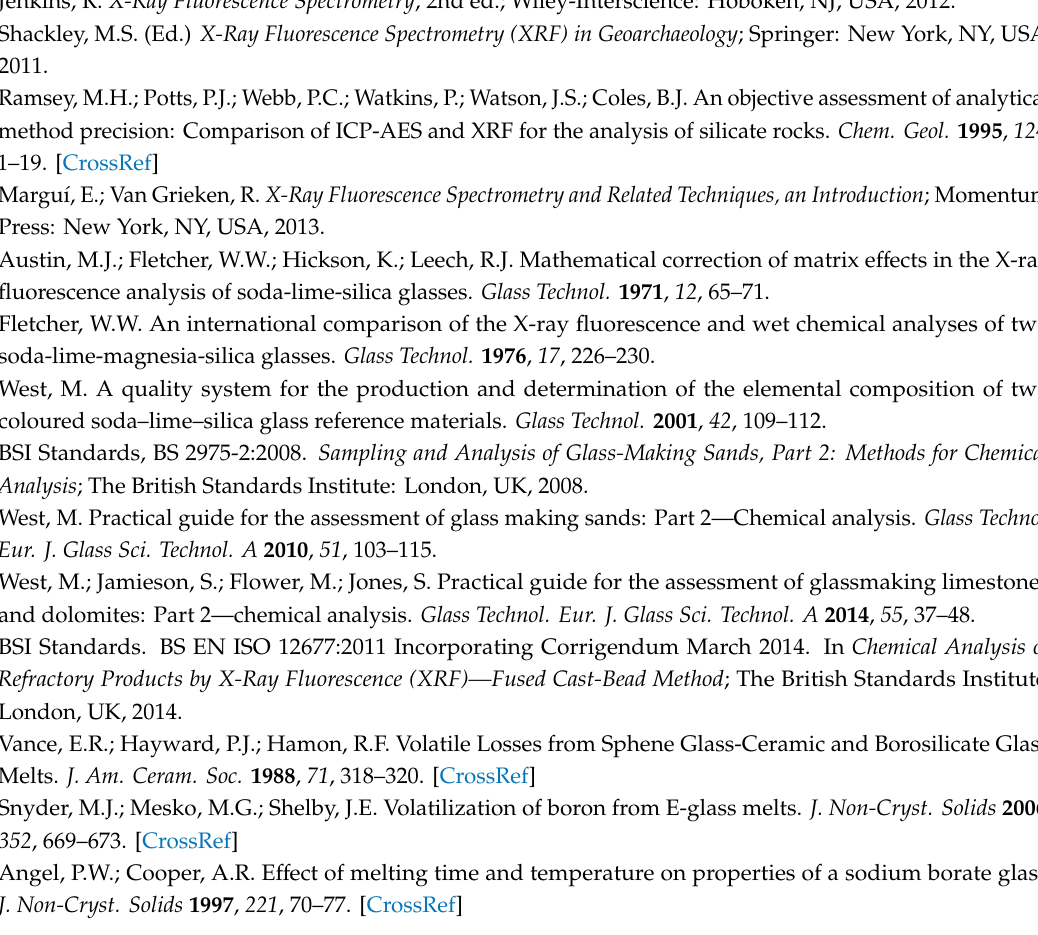
2 content includes contribution